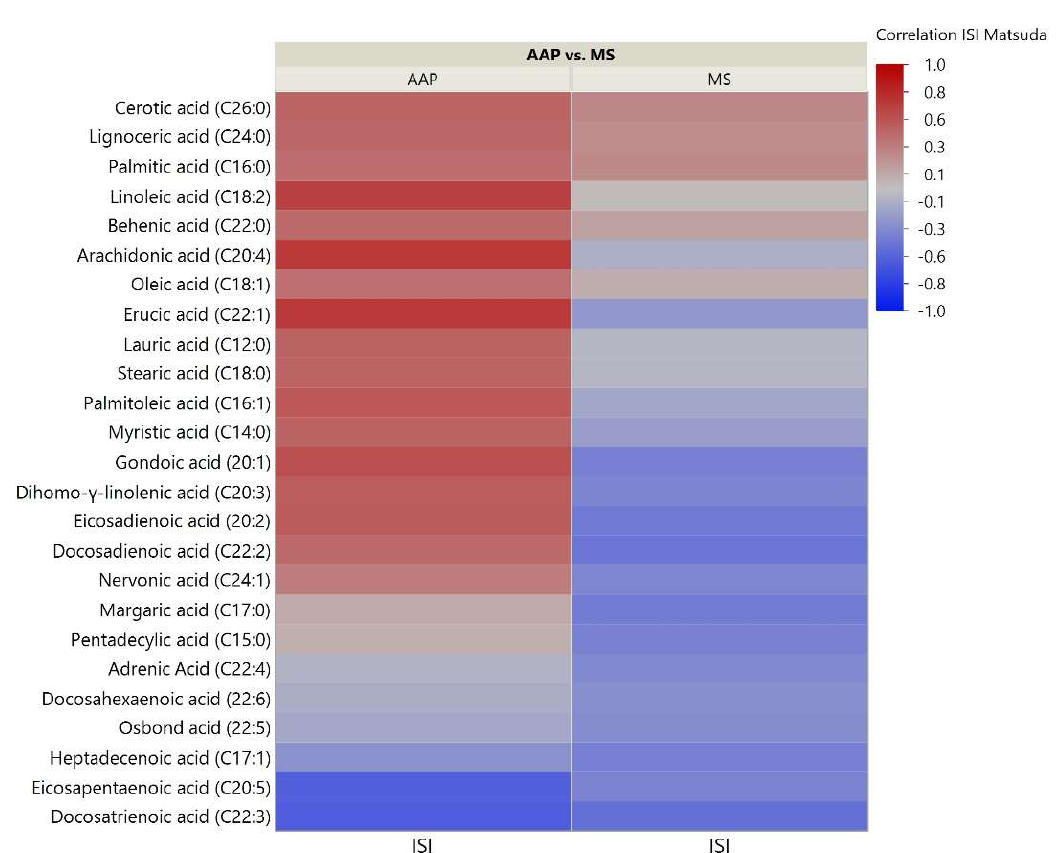
Figure 3. Correlation heatmap of insulin sensitivity and PC Lipids. The heatmap shows degree of correlation between individual PC species and insulin sensitivity measured by the Matsuda ISI. Lipids are ordered by the average ascending correlation value. AAP: atypical antipsychotic, and MS: mood stabilizer.